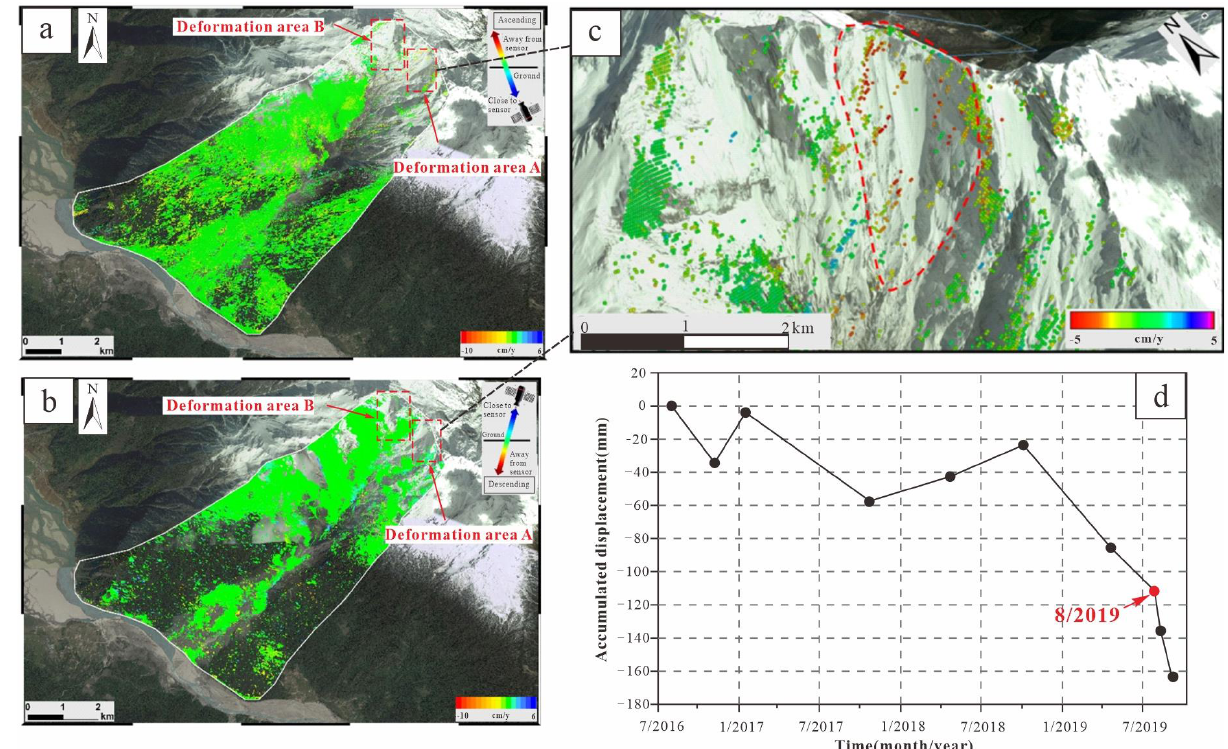
Figure 7. InSAR monitoring results of the Yigong landslide. ( a ) the annual average surface diplace- ment rate of the ALOS/PALSAR-2 image radar ascending track image; ( b ) the annual average surface displacement rate of the ALOS/PALSAR-2 image radar descending track image; ( c ) the ascend- ing annual average surface displacement rate of potential deformation area A; ( d ) the ascending accumulation displacement curve of potential deformation area A.